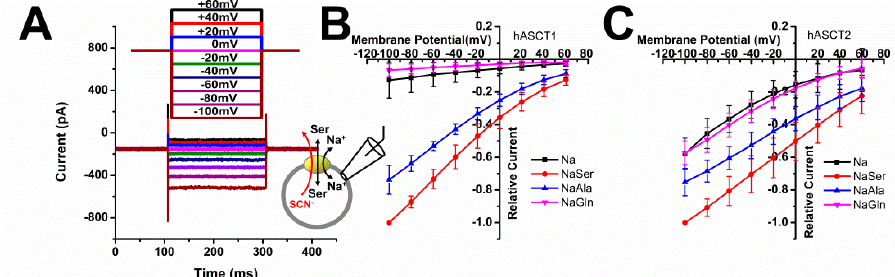
Figure 2. Voltage dependence of substrate-induced and leak anion currents. ( A ) Typical current recording in response to voltage jumps (from − 100 to + 60 mV, in increments of 20 mV for the duration of 200 ms, voltage protocol shown at the top) from an ASCT1-transfected cell in the presence of extracellular NaMes and intracellular NaSCN with 10 mM serine. 400 µ M (R)-gamma-(4- Biphenylmethyl)-L-proline was used to eliminate the unspecific background currents by subtraction. The anion current-voltage relationship at steady-state is plotted in ( B ) for ASCT1 and ( C ) for